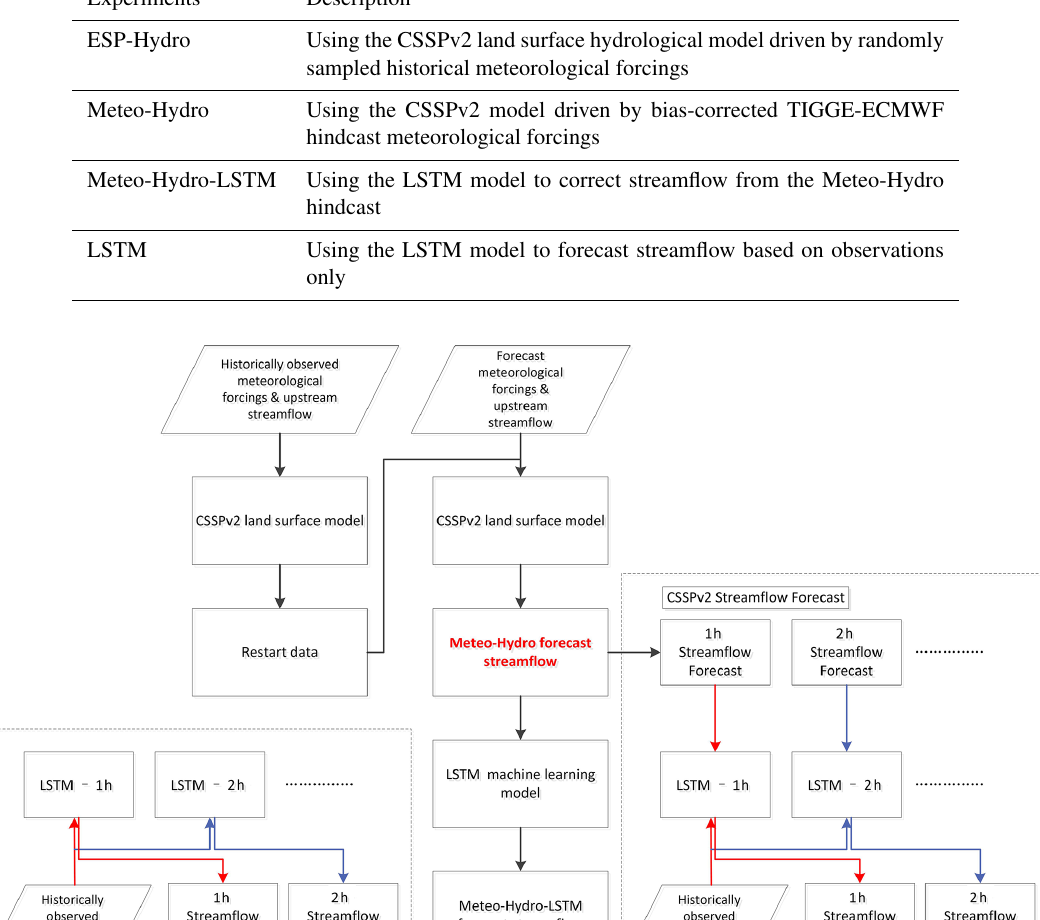
better NSE than the upstream grids. The NSE values of the grids in the southern part are greater than 0.5, which ac- counts for two-thirds of the interval basin area. Higher NSE values in the upstream part of Jiazhuan station (Fig. 1) are due to the more humid climate (not shown), as hydrological models usually have better performance over wetter